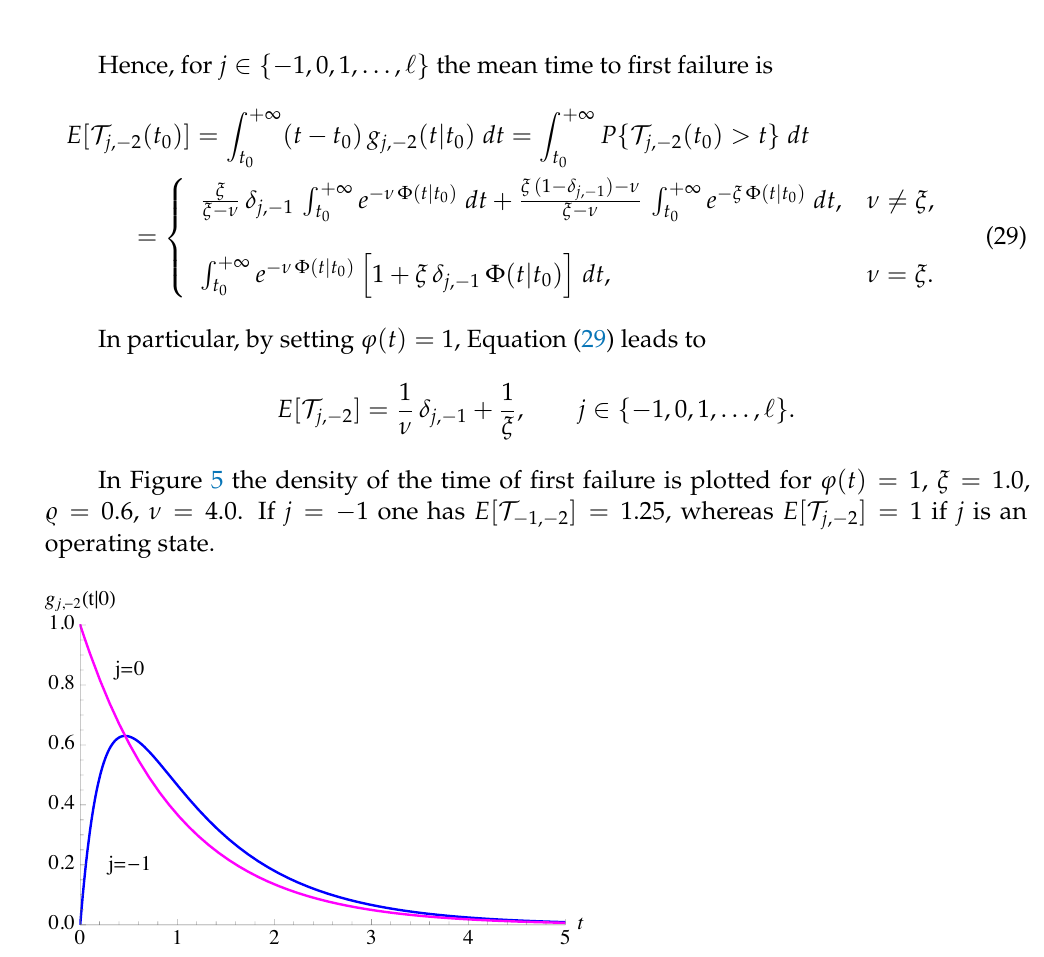
Figure 5. The density of the time of first failure is plotted for ϕ ( t ) = 1 and for ξ = 1.0, (cid:36) = 0.6, ν =